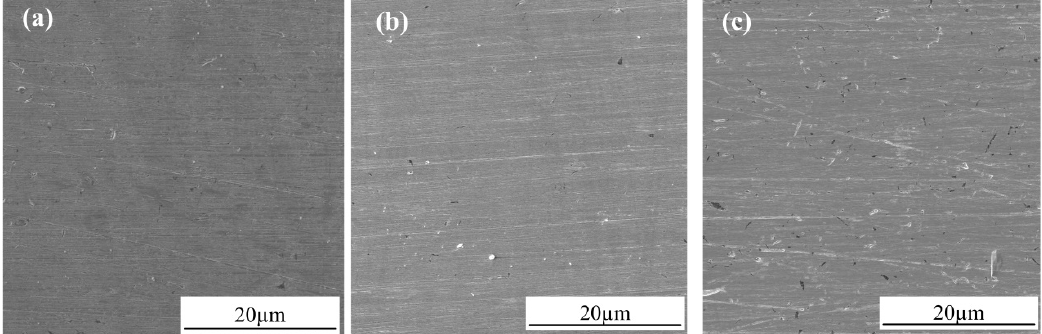
Figure 2. Micro ‐ corrosion morphology of the samples without stress at 90 C, with different experimental conditions ( a ) P H2S = 0.1 and P CO2 = 4 MPa, ( b ) P H2S = 0.5 and P CO2 = 4 MPa and ( c ) P H2S = 1 and P CO2 = 4 MPa.